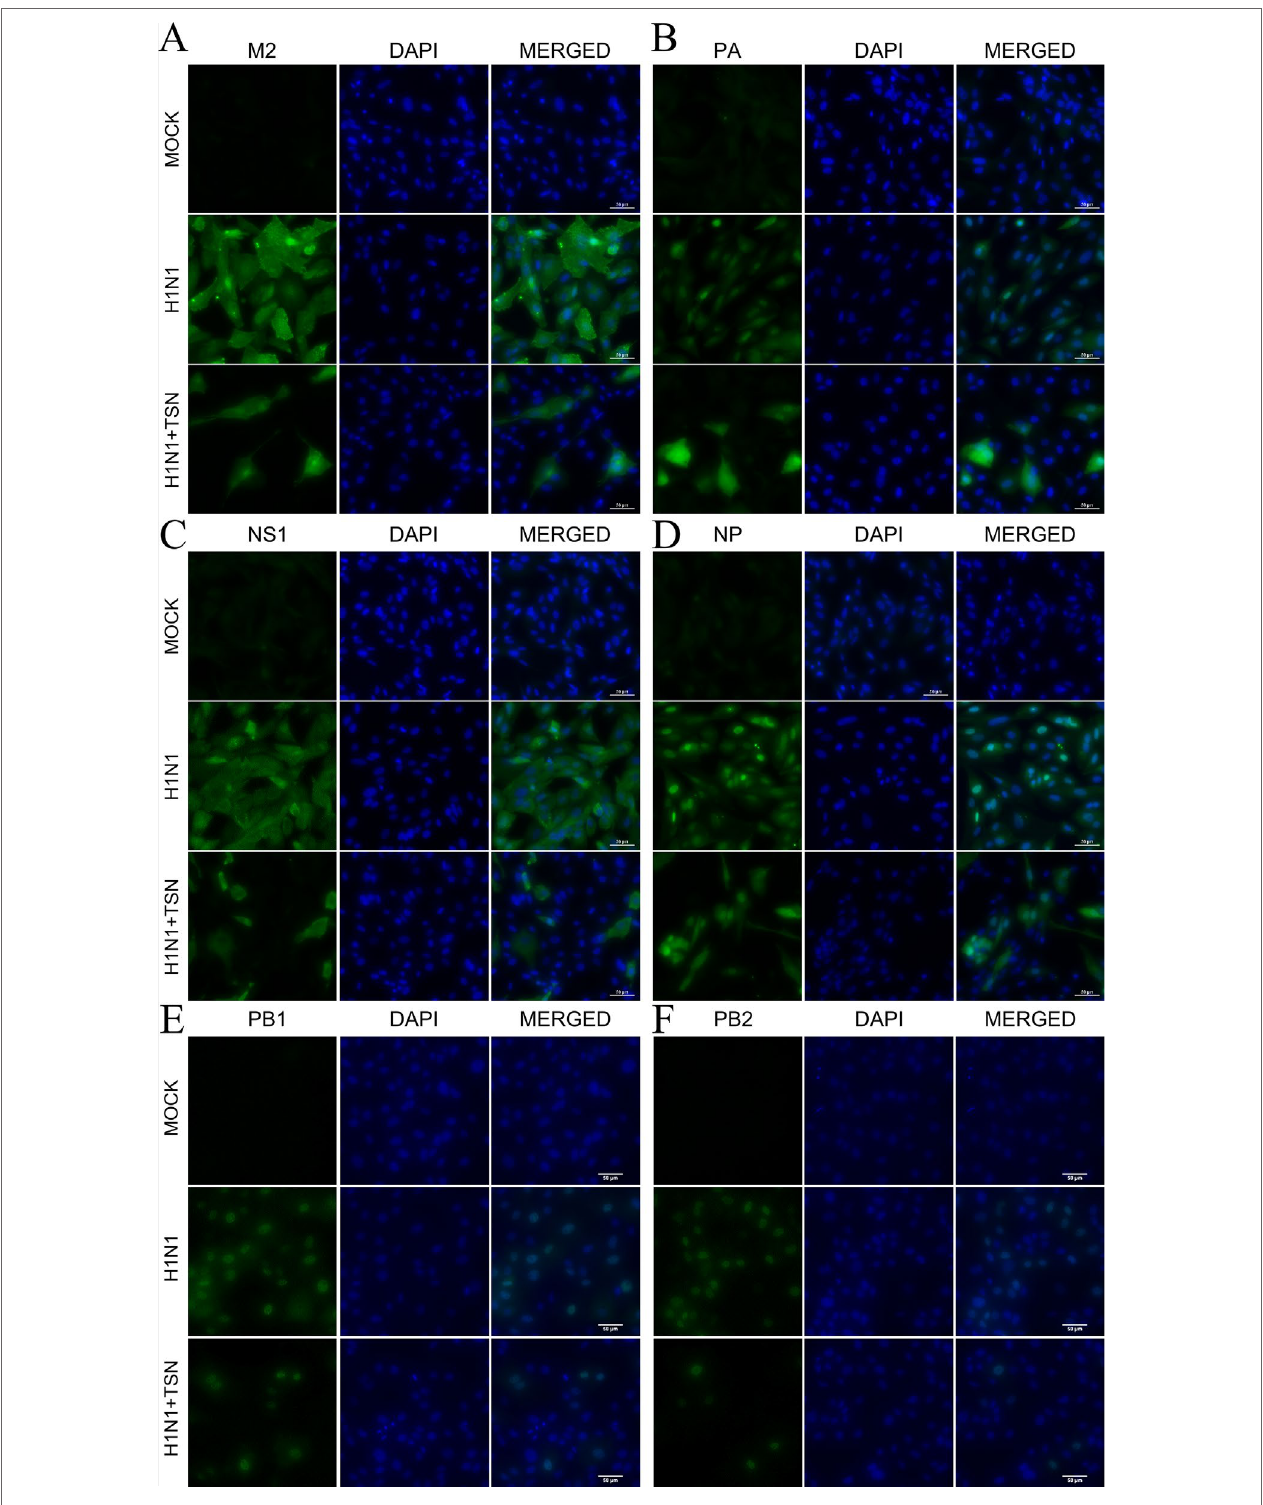
FIGURE 6 | TSN pretreatment reduced viral M2, PA, NS1, NP, PB1, and PB2 protein expression levels and altered PA protein subcellular localization. MDCK cells were pretreated with TSN (2 µM) and then infected with 10 MOI A/PR/8/34. Cells were immunostained at 18 hpi. Green foci indicated the presence of M2 (A) , PA (B) , NS1 (C) , NP (D) , PB1 (E) , or PB2 (F) viral proteins (left column). The nucleus was counterstained with DAPI (blue, middle column). Merged images indicate the subcellular localizations of immunostained proteins (right column). Data are representative of three different experiments. H1N1, control virus-infected MDCK cells. Scale bars, 50 µm at ×40